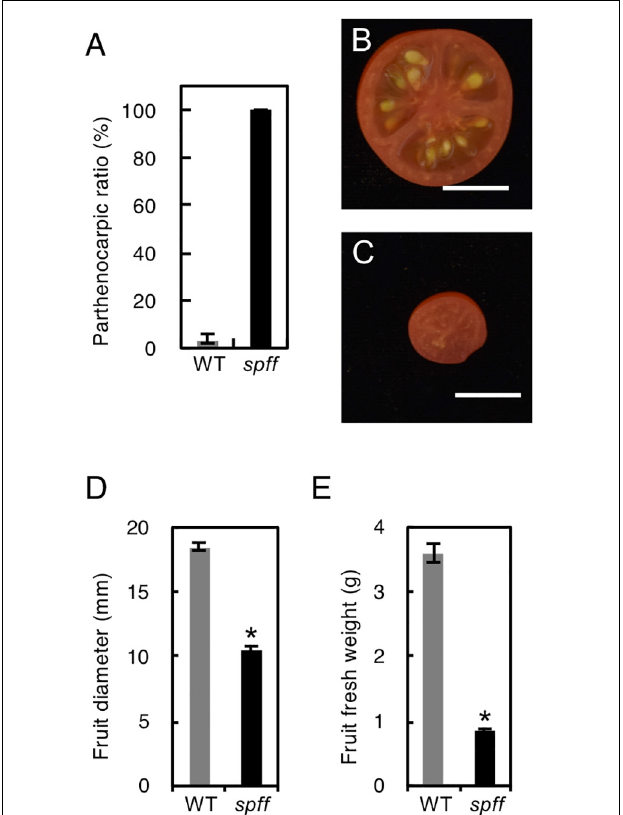
FIGURE 3 | Ovary wall histology in WT and spff . Transverse ovary wall sections of WT (A) and spff mutant (B) at anthesis. Number of cell layers (C) and cell size (D) in WT and spff ovary walls. Bars are 30 µ m. At least three biological repetitions were performed and their mean values with SE are shown. Asterisks indicate significant difference between WT and spff mutant (Student t test, p < 0.01).